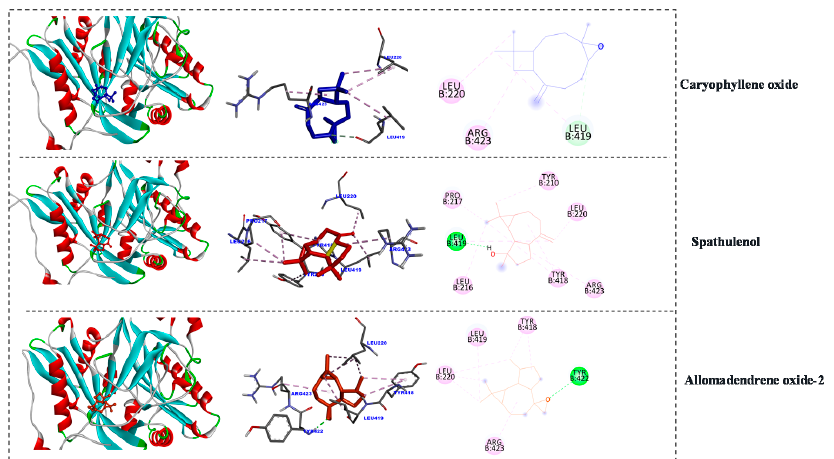
Figure 4. 2D and 3D representations of the predicted binding modes, as well as the docking scores, of EO major compounds inside the active site of 1IYK (antifungal).